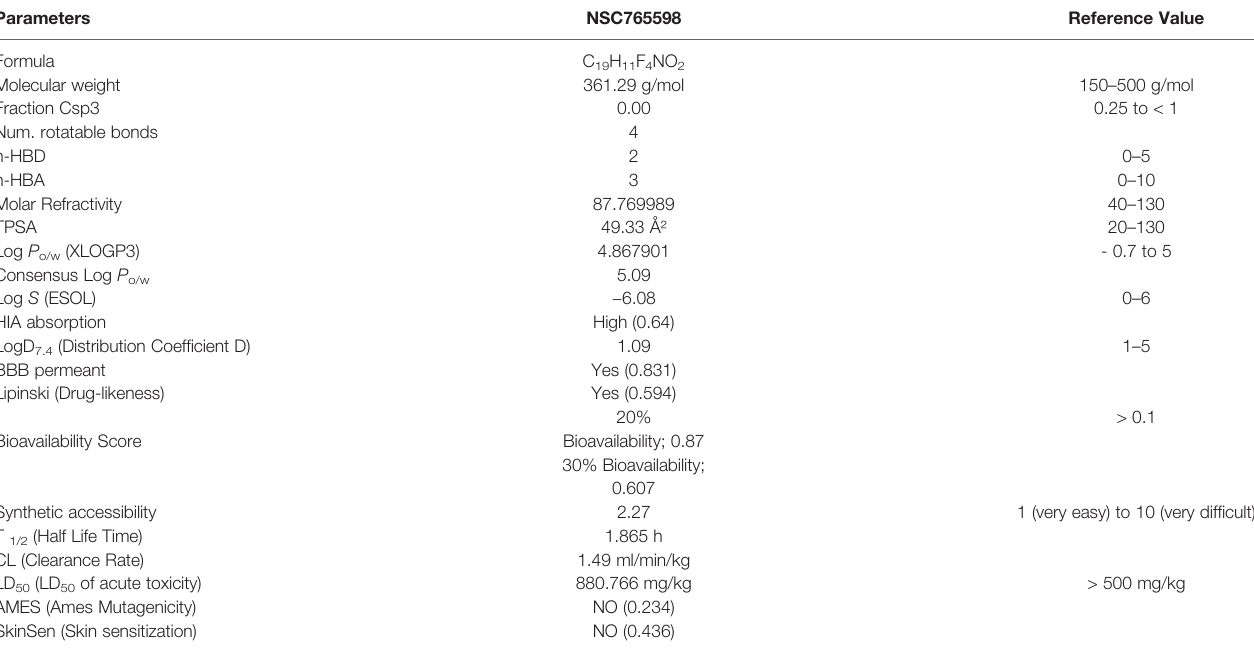
TABLE 1 | Drug likeness, medicinal chemistry, physicochemical, and ADMET properties of NSC765598.